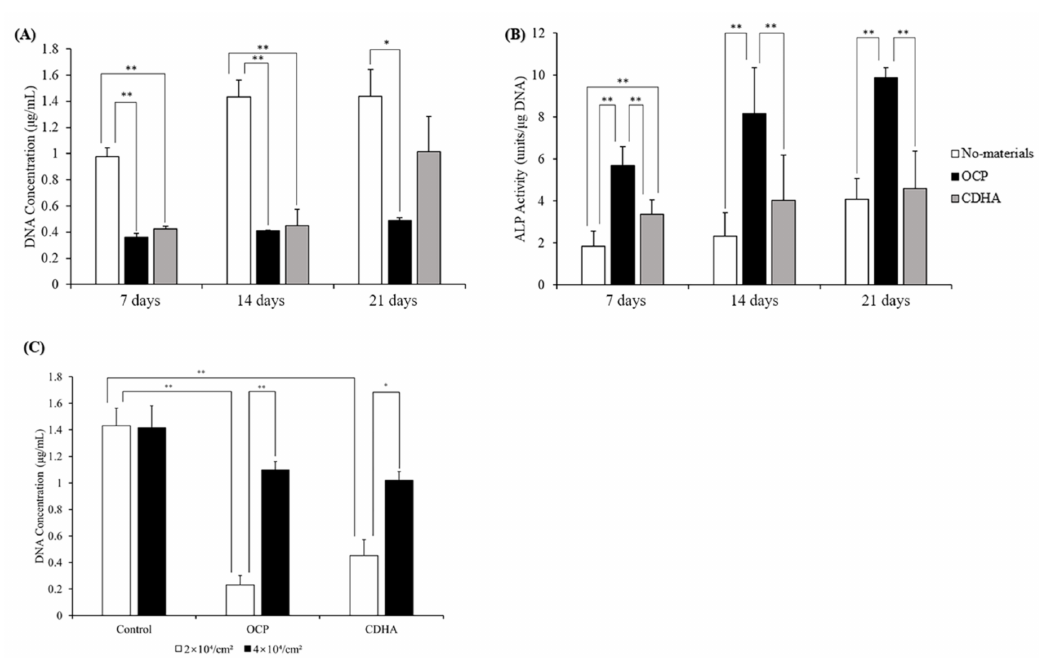
Figure 3. Responses of TSPCs to calcium phosphate granules; ( A , B ) the DNA ( A ) content and ALP activity ( B ) of TSPCs treated with or without 4 mg of OCP and CDHA granules; ( C ) the DNA content of different seeding density on day 14 ( n = 3); ** p < 0.01, * p <